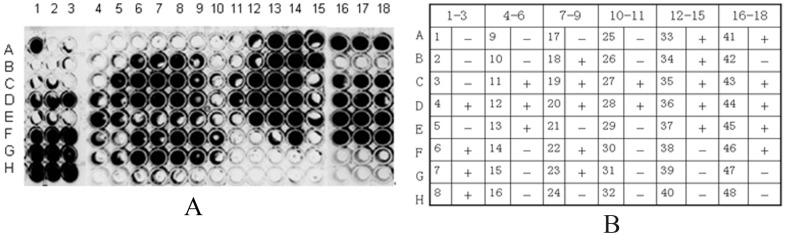
Chemiluminescence assay for phage binding activity with CD14.A. The luminescent particles were single clones with binding activity (3 independent experiments done in duplicate). A1–3, and B1–3 to H16–18 (3 independent experiments done in duplicate) were for samples 1 to 48, respectively. B. Chemiluminescence plate in (A). Corresponding single clone numbers and binding activity status. “+” indicates binding activity, “−” indicates no binding activity.